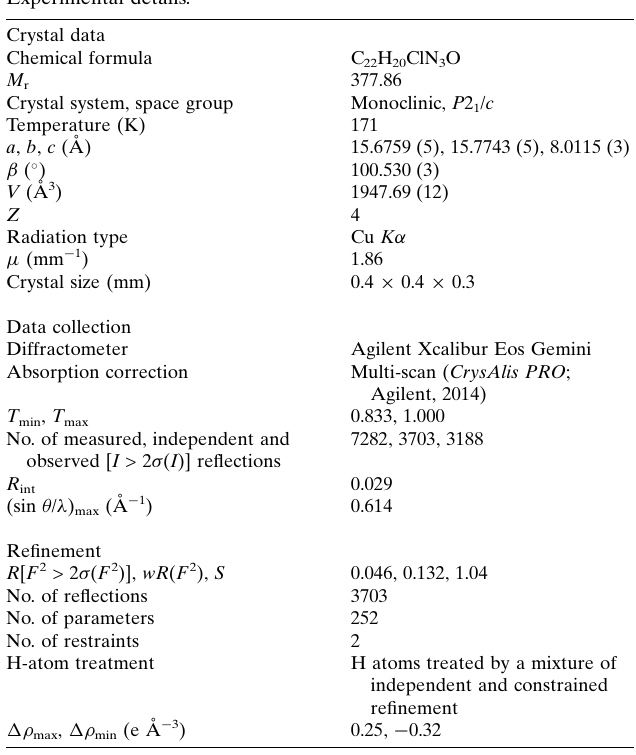
Table 2 Experimental details.